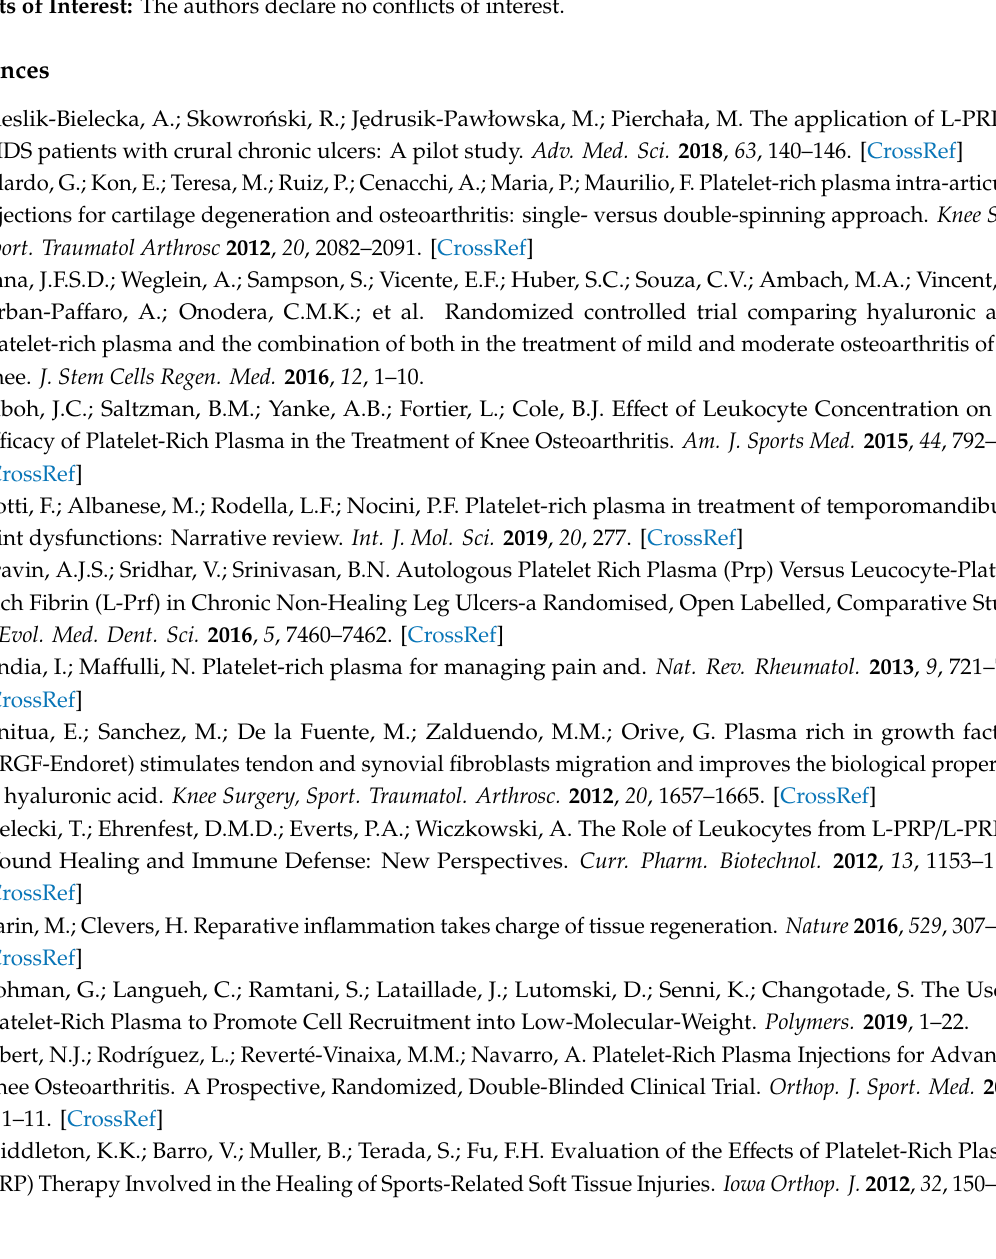
Figure S1: Concentration of ( A ) platelets, ( B ) leukocytes, ( C ) lymphocytes and ( D ) granulocytes in L-PRPs of the donors 2 and 3, as measured in a hematologic analyzer. The calculated ratios of ( E ) platelet / leukocyte from ( A , B ) and ( F ) lymphocyte / granulocyte from ( C , D ). Note: * p < 0.05. Figure S2: Kinetics of the GFs ( A ) TGF- β 1, ( B ) PDGF-BB, and the inflammatory cytokines ( C ) IL-8 and ( D ) TNF- α released for 72 h from fibrin